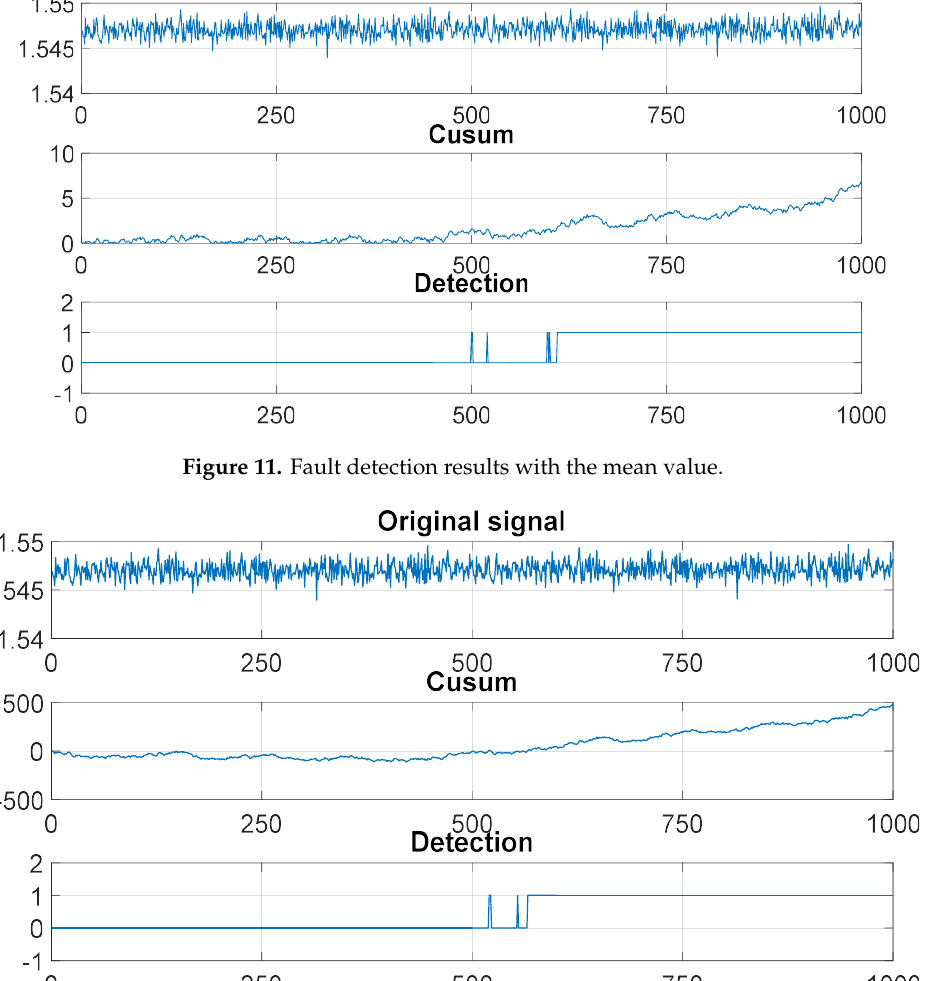
( b ) Figure 13. 100 µs OSF detection performance for 20 rad/s and 50% of the load: ( a ) With mean value, ( b ) With variance.